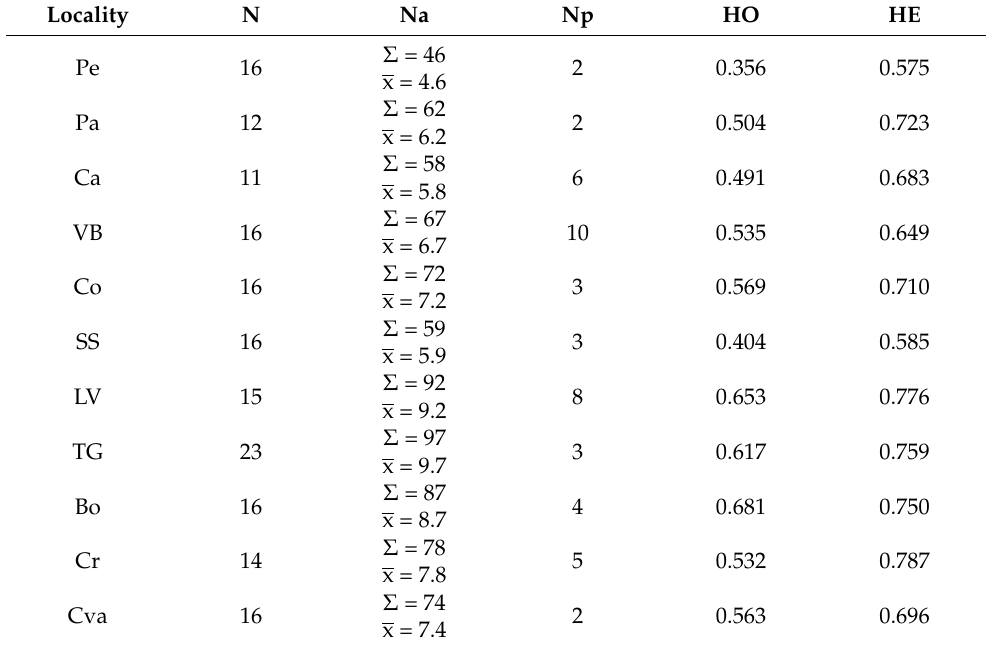
Table 3. Genetic diversity statistics with microsatellites for each locality. Sum and average alleles per locus (Na); unique alleles (Np); observed heterozygosis (HO), expected heterozygosis (HE). Abbreviations in each locality are as in Figure 1.